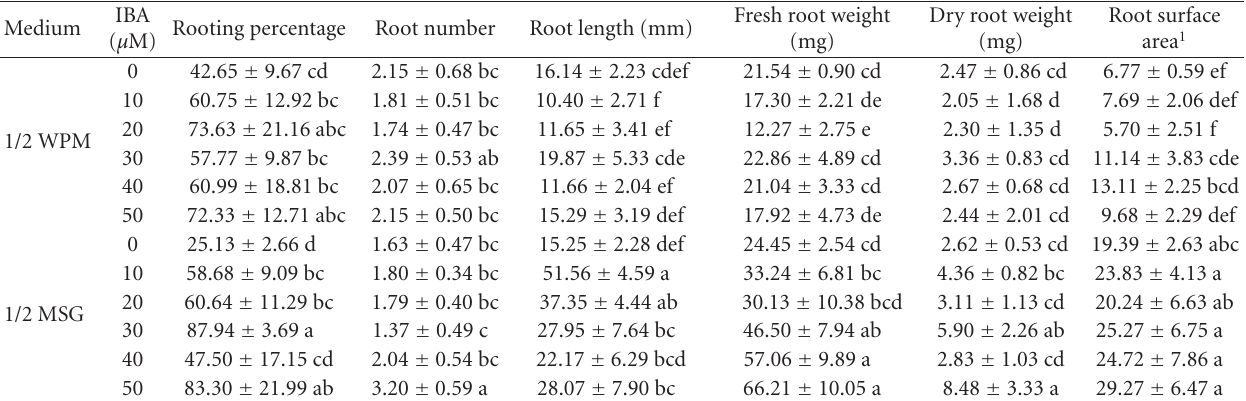
Table 4: E ff ect of indole butyric acid (IBA) concentration and di ff erent formulations of basic culture media (1/2 WPM, 1/2 MSG) on root development parameters of in vitro rooting of Handroanthus impetiginosus with three days of auxin pulse induction, after 40-day culture. Medium